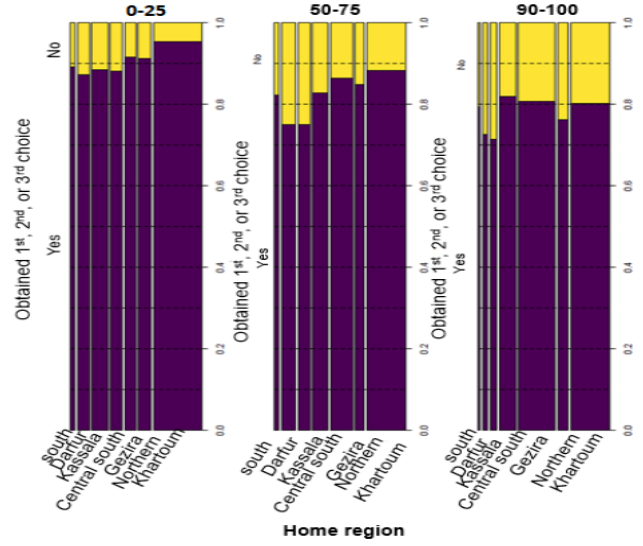
Figure 17. Percentage of diploma (2016–2017) applicants receiving first, second, or third choice by Home region for different rank percentile ranges (0–25%, 50–75%, 90–100%).